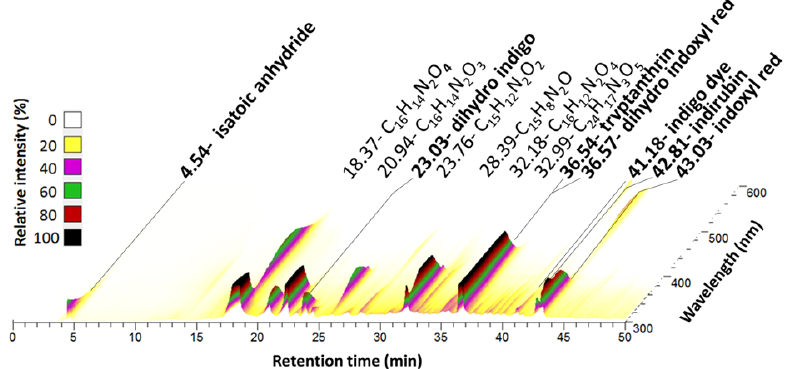
Figure 7. HPLC-PDA chromatogram of indole SOA. The absorbance is plotted as a function of both retention time and wavelength. Peaks are labelled by their PDA retention time followed by their proposed assignment. Bold-faced assignments are specific isomers that are discussed further in the text. Note the reference line for dihydro indigo points to a small peak between two larger peaks that obscure it in this projection.